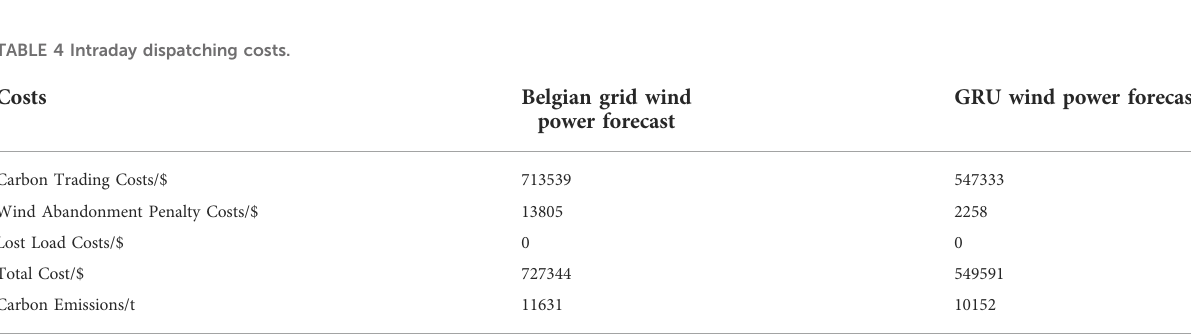
TABLE 4 Intraday dispatching